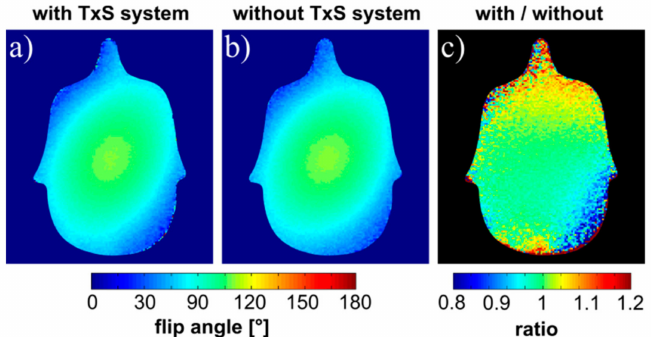
Figure 5. Flip angle maps. Maps represent the distribution of the RF transmit field generated by the body coil, which was also used for reception in these measurements. FA maps with ( a ) and without ( b ) the TxS system, ( c ) ratio map.